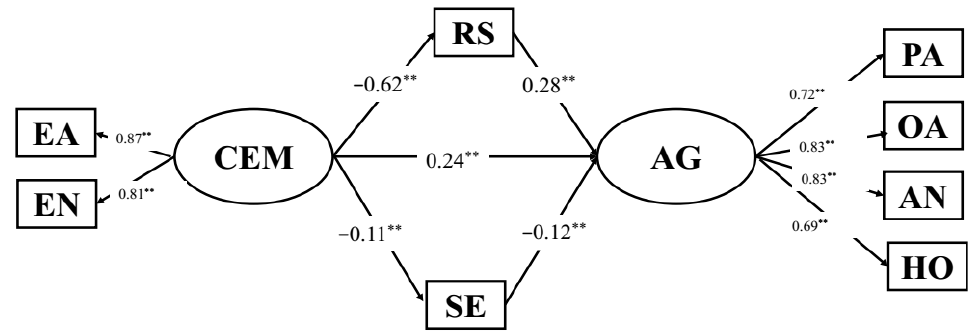
Figure 1. Standardized parameter estimates of the structural model demonstrating effects of CEM on aggression via resilience. Note: N = 809; EA: emotional abuse; EN: emotional neglect; PA: physical aggression; VA: verbal aggression; AN: anger; HO: hostility; CEM: childhood emotional maltreatment; AG: aggression; RS: resilience, ** p < 0.01.